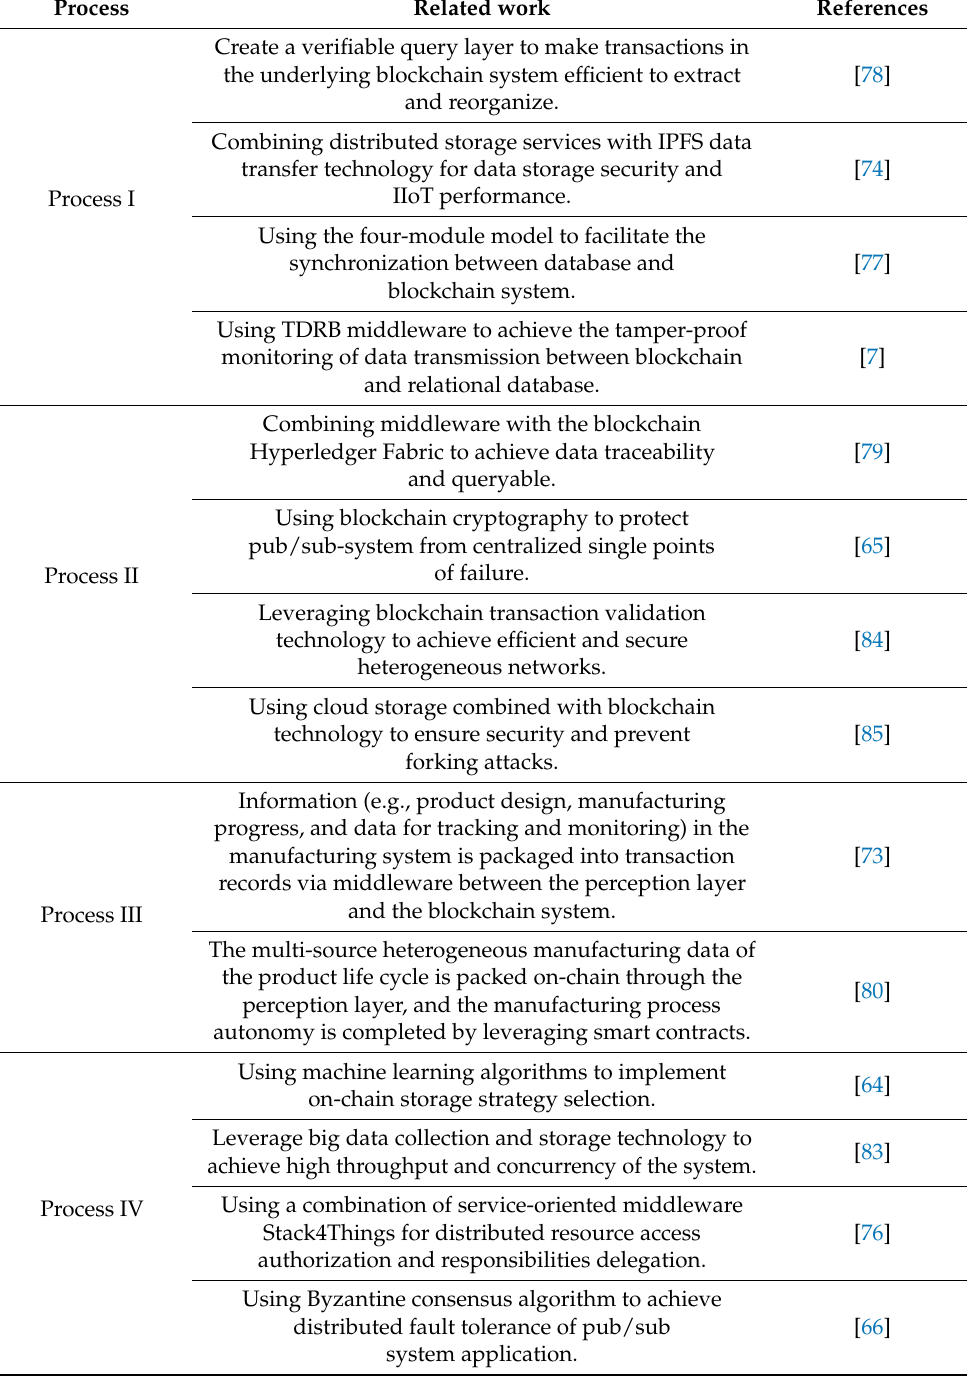
Table 3. Related work on four processes in the architecture of blockchain